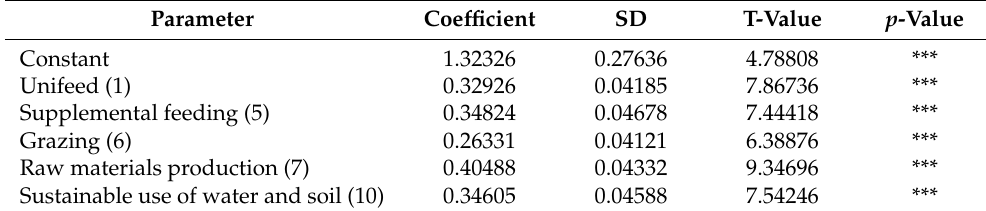
Table 4. Multiple regression